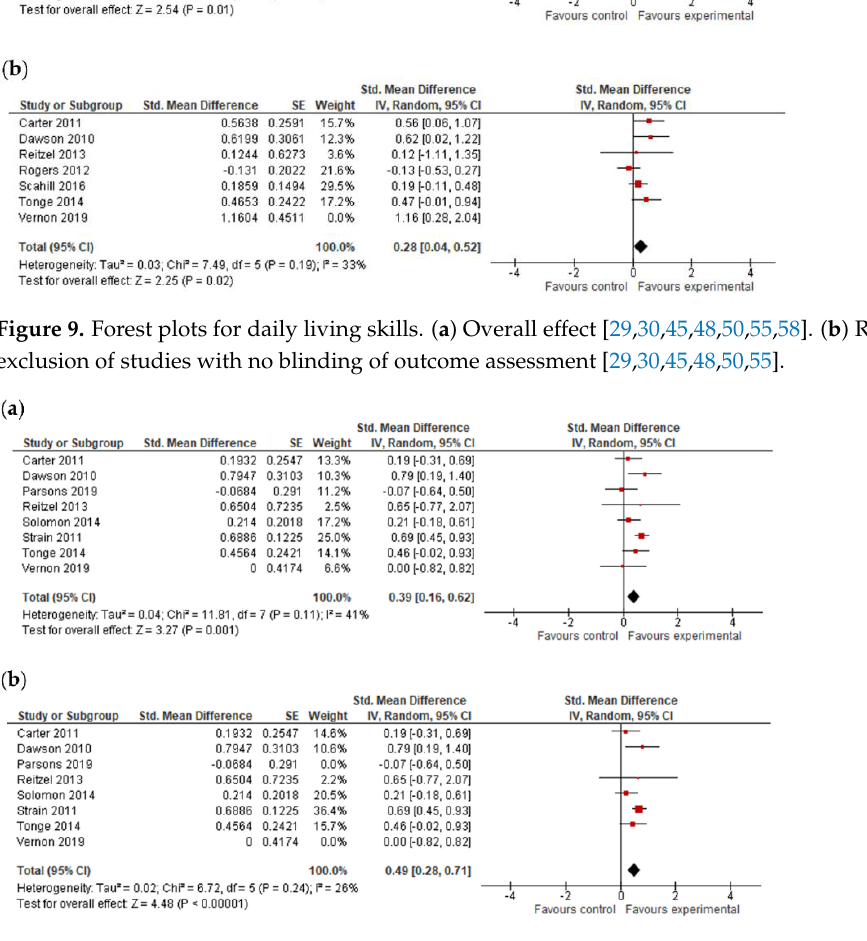
Figure 10. Forest plots for motor skills. ( a ) Overall effect [29,30,43,45,53–55,58]. ( b ) Results after ex- clusion of studies with no blinding of outcome assessment [29,30,45,53–55].